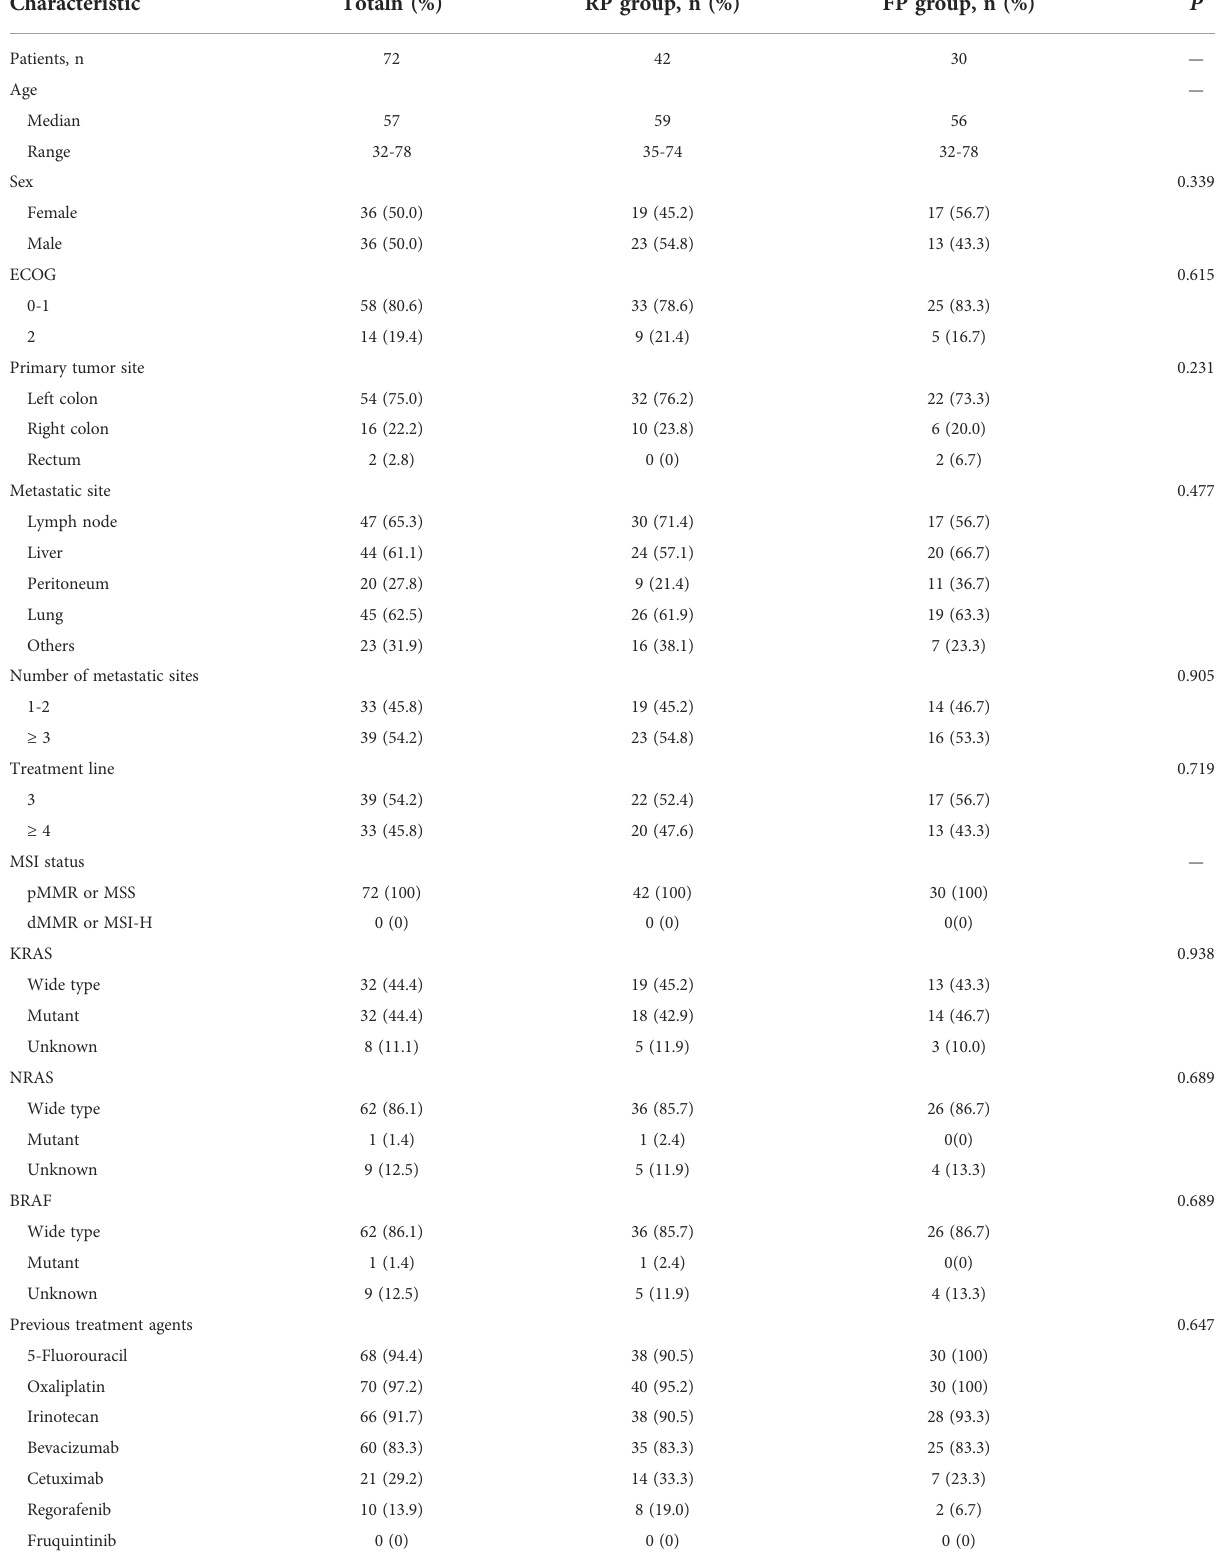
TABLE 1 Patient and treatment